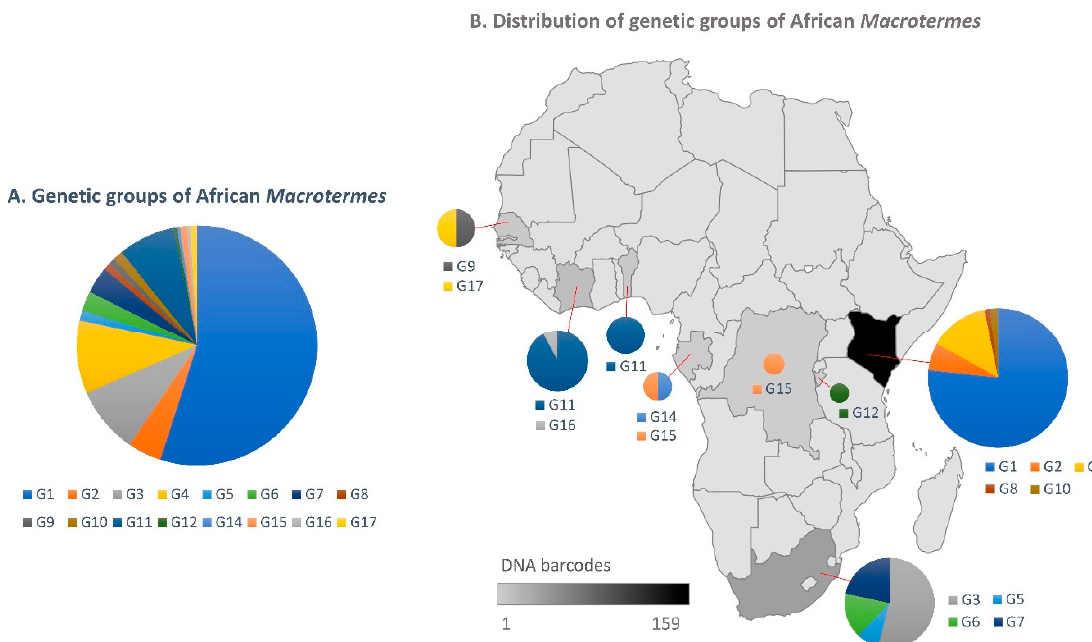
Figure 4. ( A ) Relative proportions of the genetic groups of African Macrotermes found in this study. ( B ) Distribution of the genetic groups in African countries. The size of the circles is proportional to the number of sequences for each genetic group.